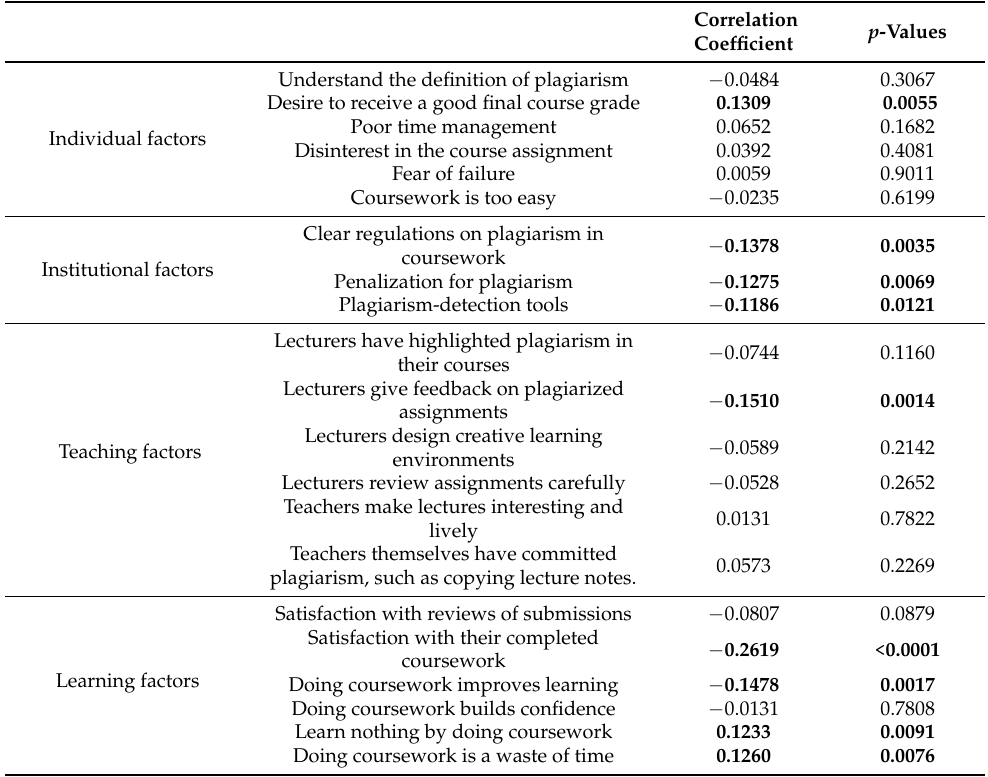
Table 7. The results of the linear correlation test. For electronic plagiarism behaviors, the individual factors, institutional factors, teaching factors, and learning factors investigated are listed, including their Pearson’s correlation coefficients and p -values. The results in bold indicate that the test supports a good correlation between plagiarism behaviors and the related factors at the 5% significance